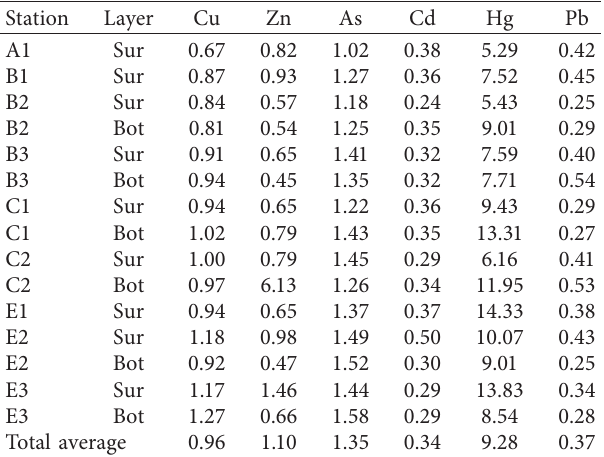
Table 6: Single-factor pollution indices for heavy metals in sea- water at all stations of Jiuzhen Bay.